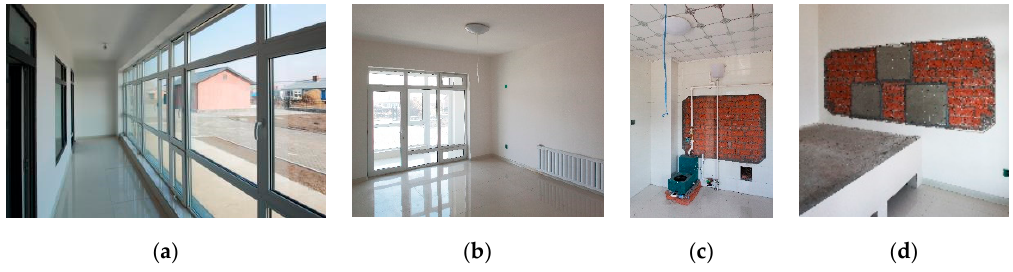
Figure 16. Inside views of the demonstration house. ( a ) Sunroom; ( b ) living room; ( c ).heating system; ( d ) phase change heat storage device in the firewall.